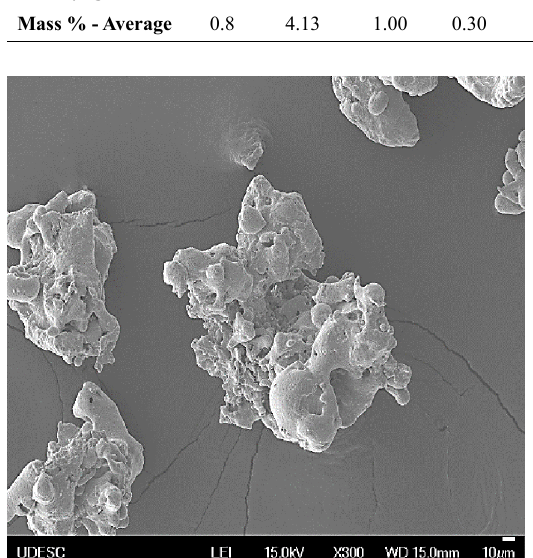
Figure 1. Powder morphology of AISI M2 HSS - SE mode.